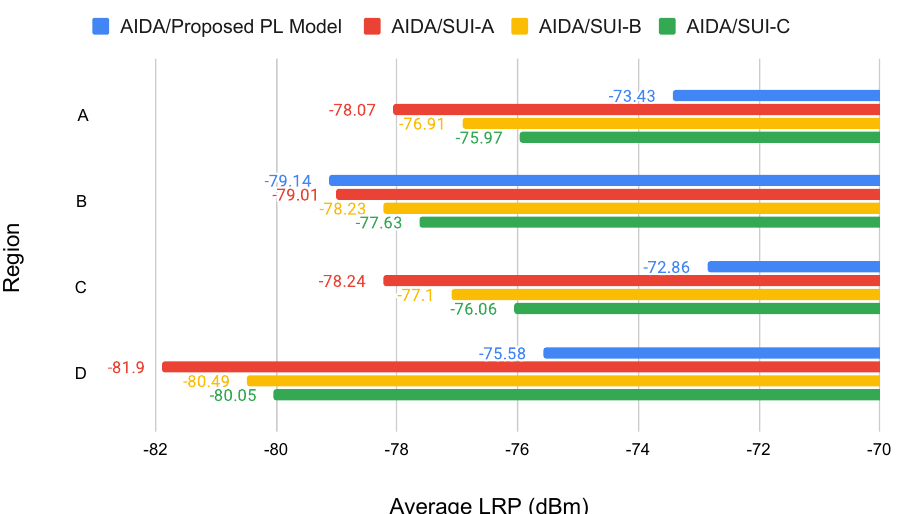
Figure 8. Average LRP values (in dBm) obtained by the AIDA method using its original path loss model (AIDA/proposed PL model) compared to the values obtained by the AIDA method using Erceg-SUI path loss model for the terrain Category A (AIDA/SUI–A), Category B (AIDA/SUI–B), and Category C (AIDA/SUI–C). The chart compares the performance of AIDA for the Regions A, B, C, and D, used in the experiments.